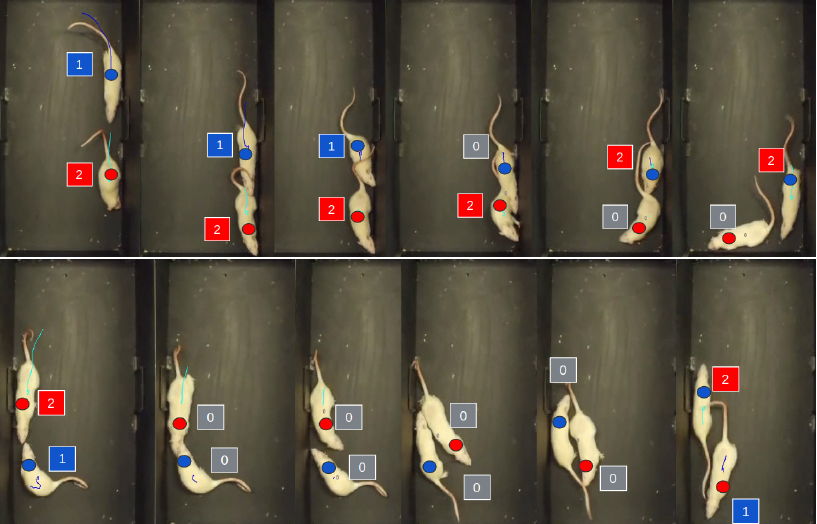
Figure 2. Two track switching examples using “ idtracker ” on our test data (cropped from the frames of the video). Ground truth labels are colored disks: blue (label 1), red (label 2). Predicted labels are within the squares. During occlusion, frame labels are lost (label 0), IDs and ground truth labels